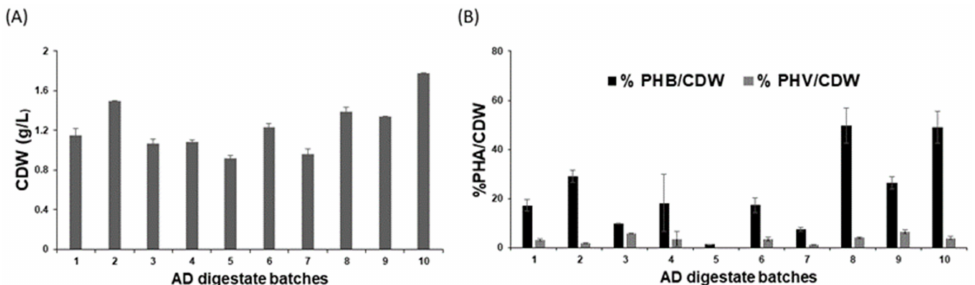
Figure 4. Biomass (( A ) and PHA accumulation ( B ) of C. necator H16 grown with Anaerobic Digestate (AD) derived VFAs. Cell dry weight (CDW ( A ), wt% PHB/CDW and wt% PHV/CDW ( B ) were measured in